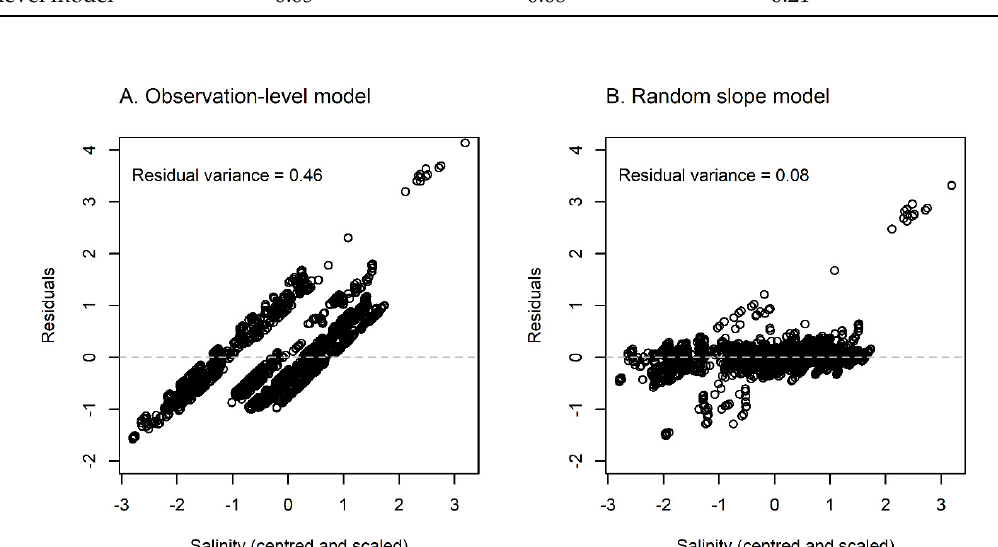
Figure 4. Salinity residual variance in ( A ) the observation-level model and ( B ) the random slope model. Note that the variance of the scaled variable is 1.